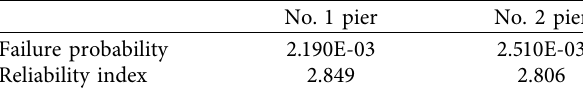
Table 6: Failure probability of